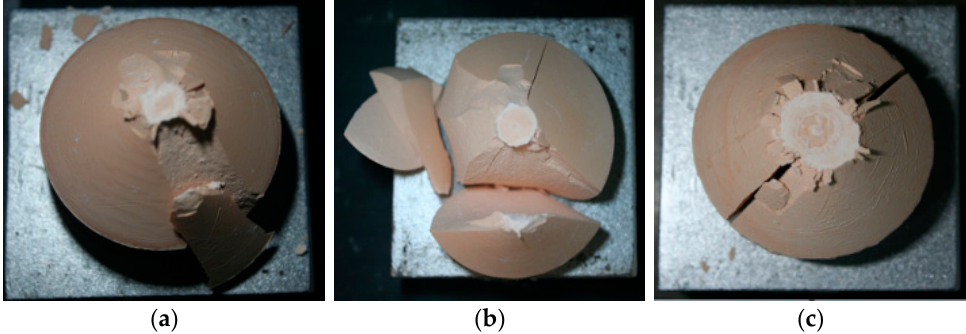
Figure 6. Photography of different breakage modes: ( a ) peeling; ( b ) peeling–splitting; ( c ) splitting.